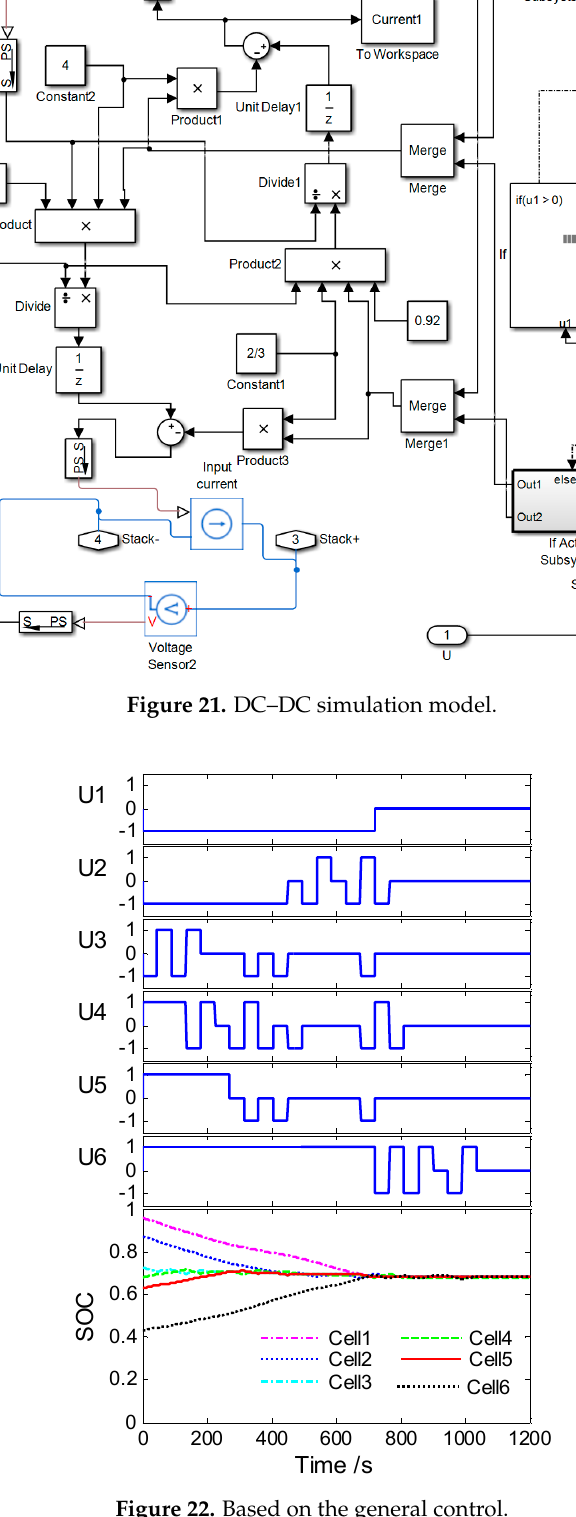
Figure 23. Based on the MPC. 5.3. Bench Test and Result Analysis